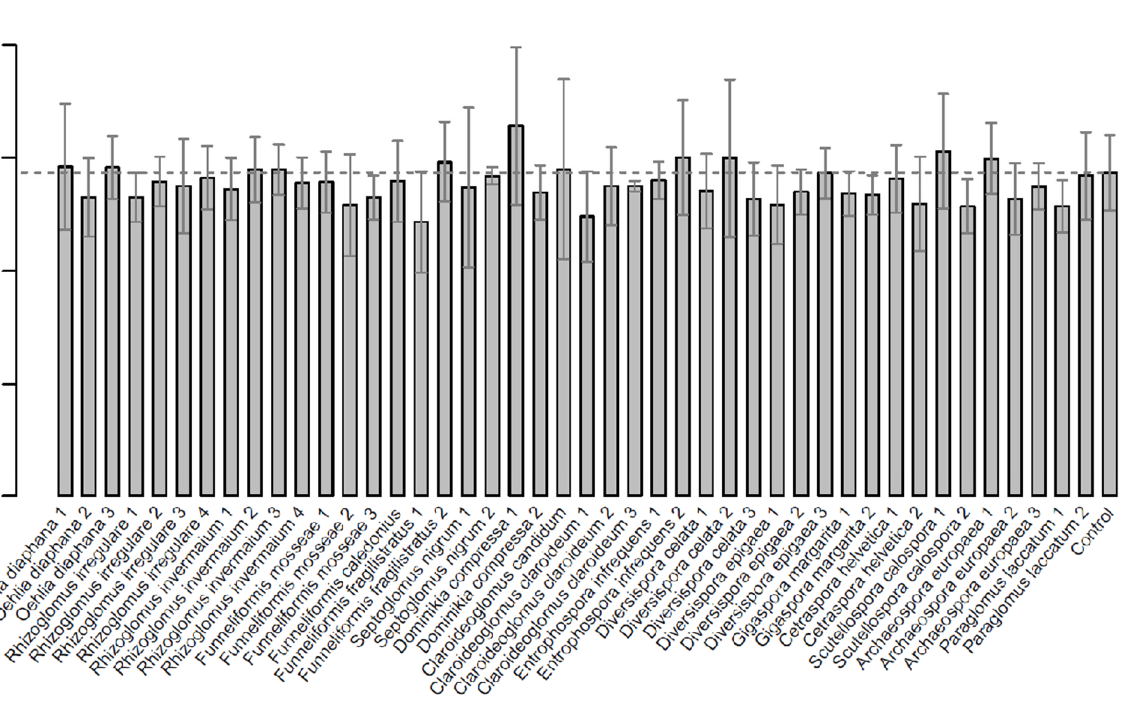
Also for Solanum nigrum no significant differences in shoot growth response to AMF inoculation were detected, neither between AMF isolates and the control, nor between different AMF isolates ( 𝜒 2 = 44.59, df = 44, p = 0.45). The mean biomass per pot of S. nigrum ranged from 1215 mg for isolate Funneliforme fragilistratus (F.fra1) to 1641 mg for D. compressa (Do.com1). The control treatment was in between with 1433 mg (Figure 2).